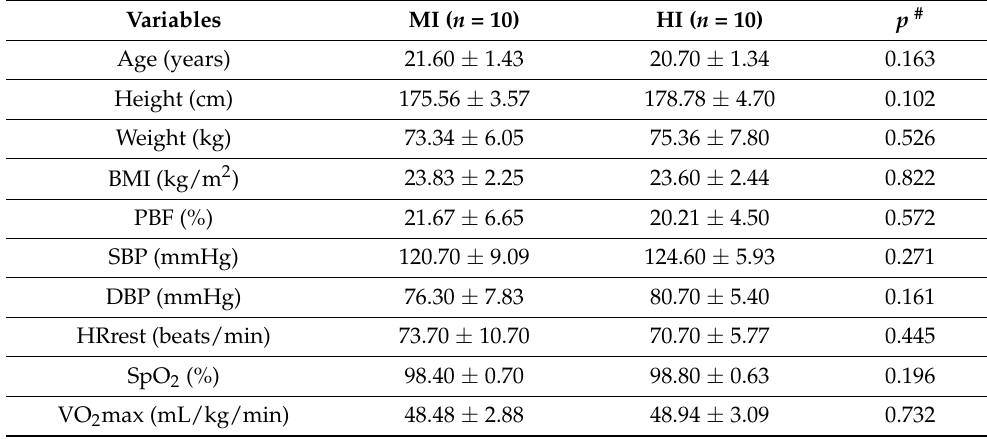
Table 1. The physical and clinical characteristics of the participants at